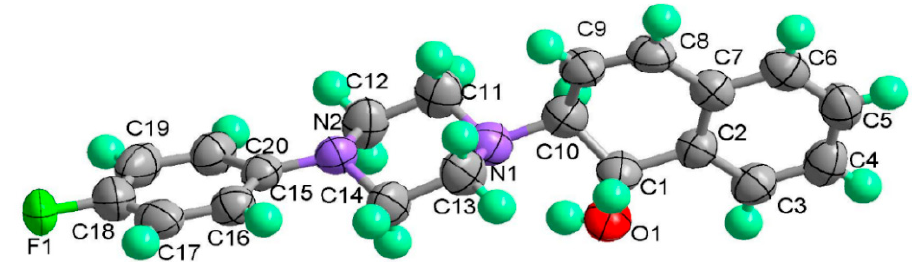
Figure 1. ORTEP plot for 2i a . a Crystal data. C 20 H 21 FN 2 O, M = 342.39. Monoclinic a = 9.572 (3), b = 10.034 (3), c = 17.732 (5), alpha = 90, beta = 90 (8), gamma = 90, T =296 K, space group. Orthorhombic,